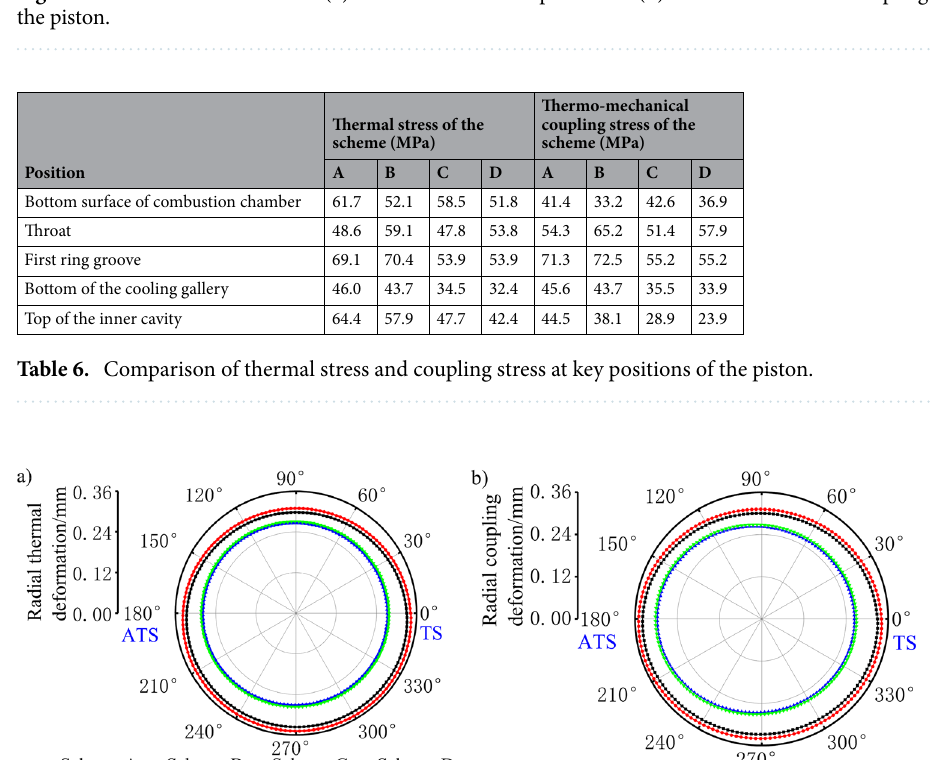
Figure 11. Results of ( a ) thermal deformation at the top of the piston and ( b ) thermo-mechanical coupling deformation at the top of the